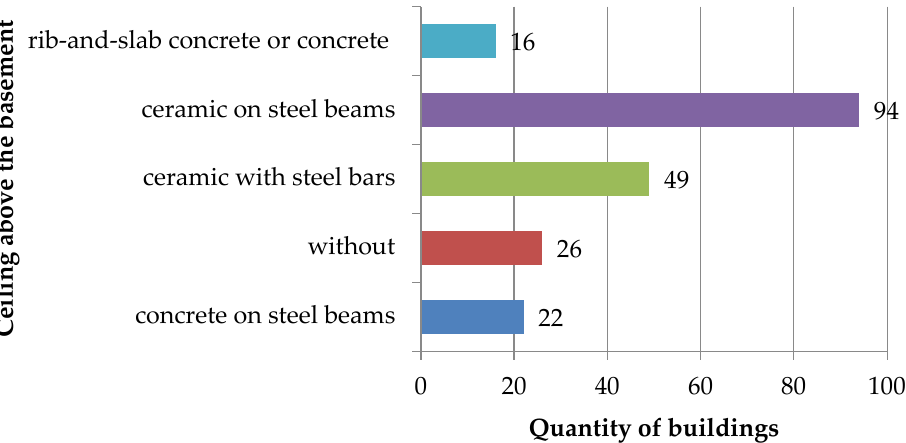
Figure 15. Distribution of data for the variable relating to the basement’s wall materials.